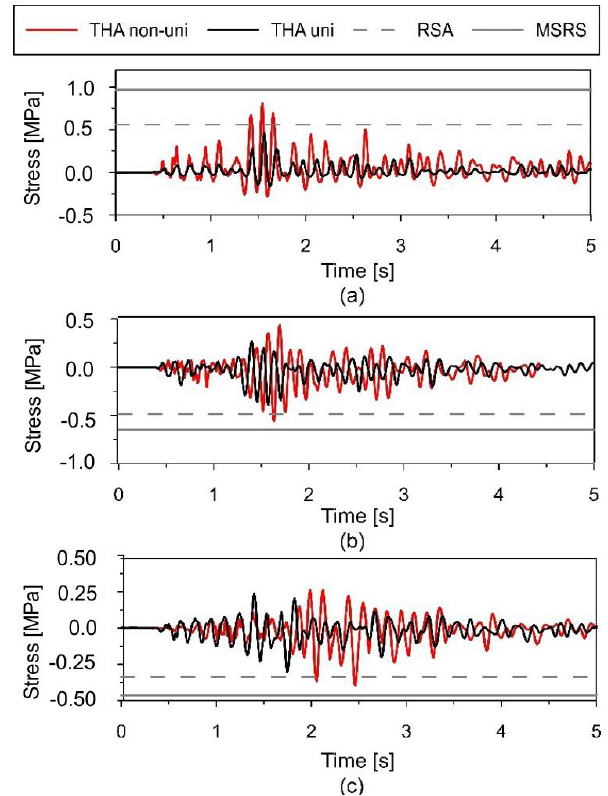
Figure 19. Comparison of extremal principal stresses obtained from di ff erent calculation methods for the mining-induced shock in the LGCD region at the support zone elements: ( a ) W4; ( b ) W5; ( c )